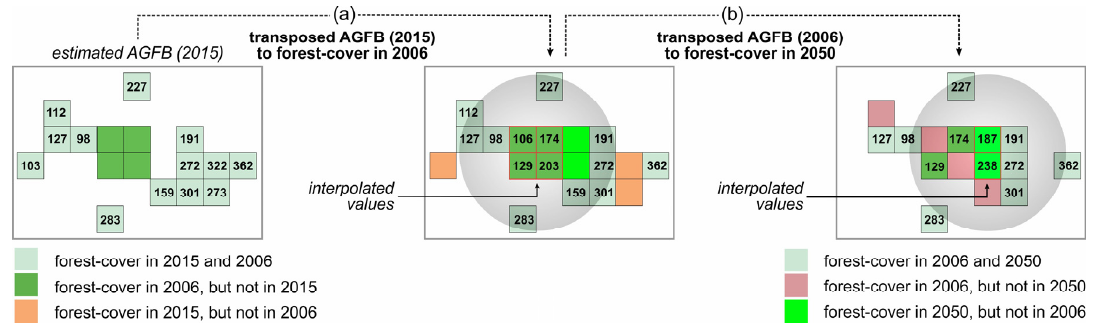
Figure 5. Synthetical illustration of the spatial interpolation procedure used to estimate the AGFB quantity for the existing forest-cover cells in 2006, but not in 2015 ( a ), and for the predicted forest-cover gain cells in 2050, respectively ( b ).